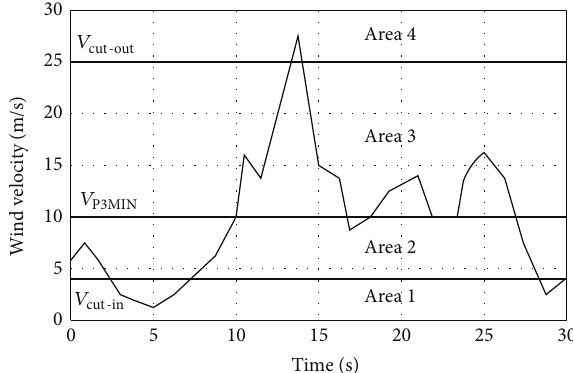
Figure 4: Course of wind velocity changes V 𝑤 = 𝑓(𝑡) with marked areas used for determining the value of statistical and energetic parameters of